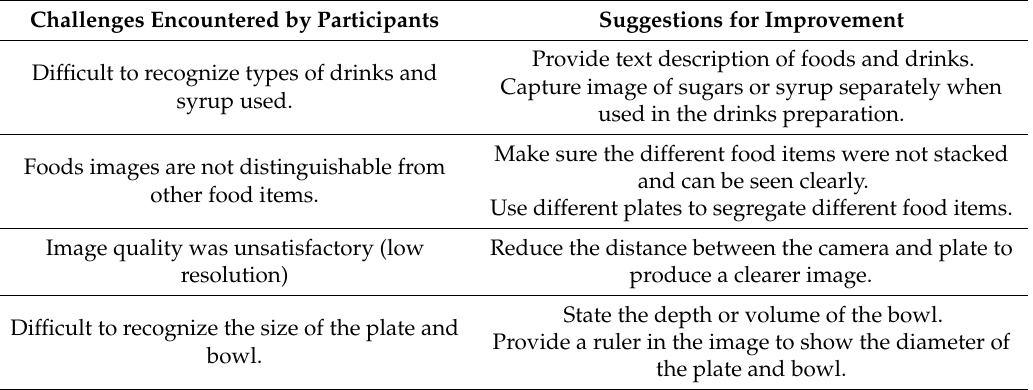
Table 7. Challenges encountered and suggestions for improvement given by